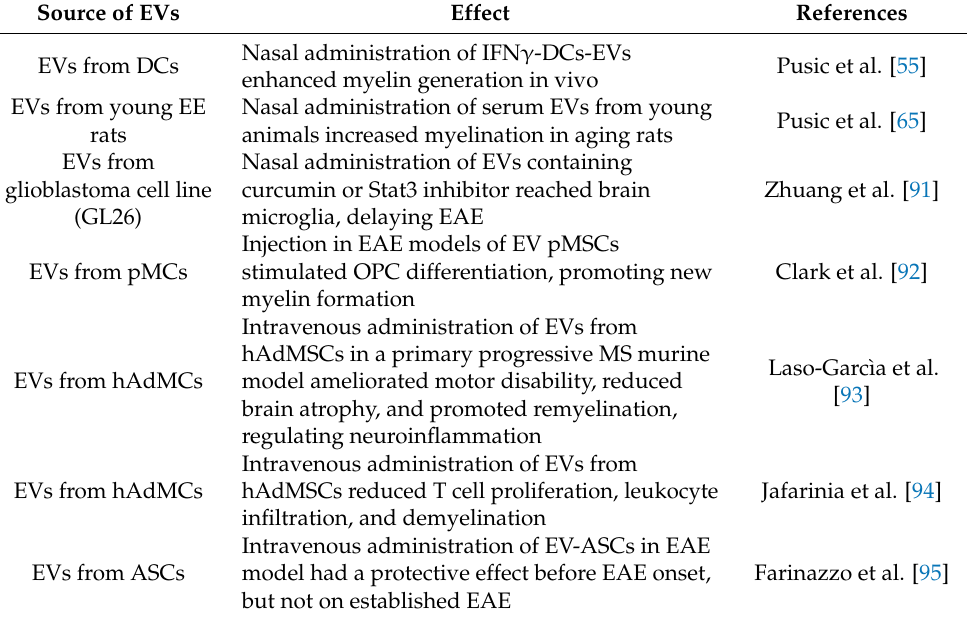
Table 2. Therapeutic applications of EVs in